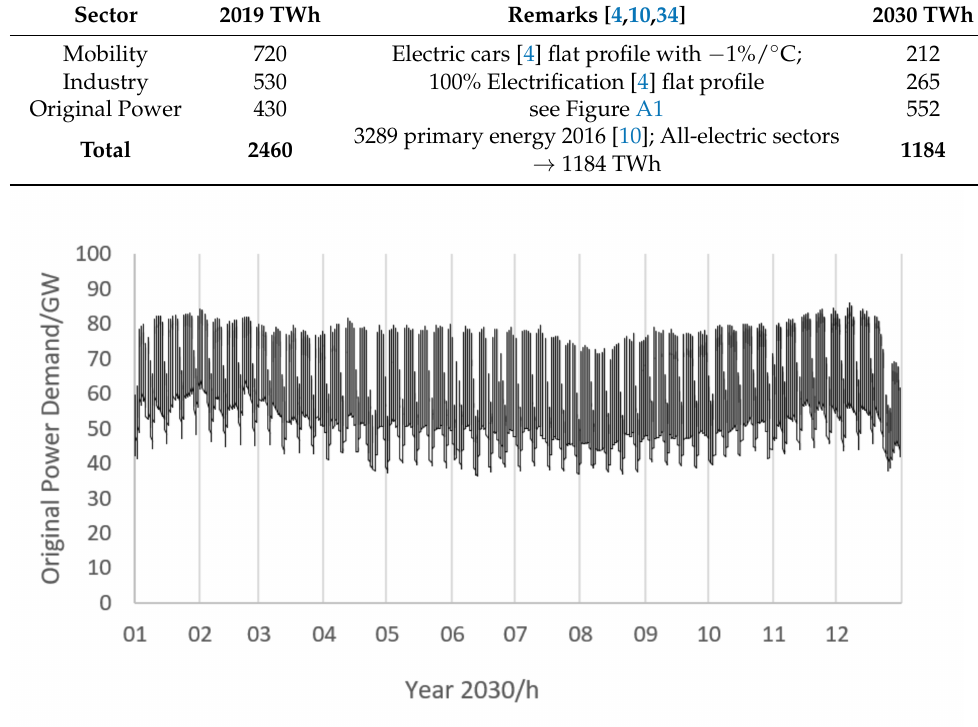
Figure A1. Germany’s power demand of 552 TWh in 2030 excluding electrification of heat, mobility, and industry, downloaded from www.agora-energiewende.de on 4 July 2016. Table A3. Parameters for generation and Storage CHP in the standard scenario with 400 GW wind power. The total cost minimum is found by Excel Solver of Windows 8.1, based on costs from Table A1.